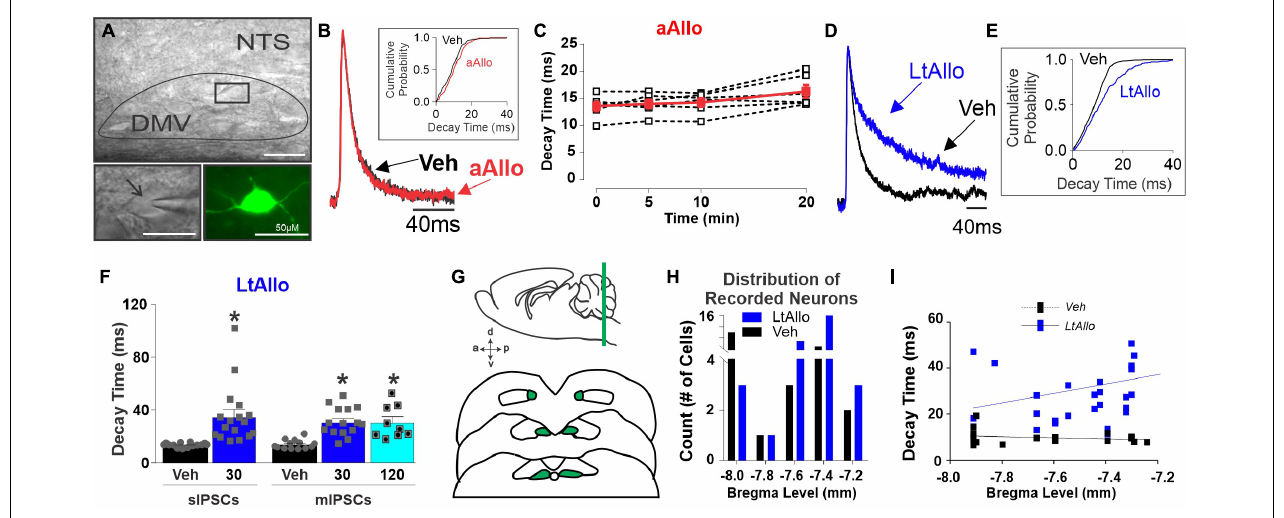
FIGURE 1 | Long-term allopregnanolone (LtAllo) in the dorsal motor nucleus of the vagus (DMV) prolongs phasic γ -aminobutyric acid A (GABA A ) receptor inhibitory postsynaptic current (IPSC) decay kinetics. (A) Top panel: Diffusion contrast imaging of representative DMV neurons with patch pipette. Bottom left panel: Magnification of boxed region in top panel containing a single DMV neuron with patch pipette. Bottom right panel: DMV neuron recovered by biotin-avidin-texas red staining (pseudo-colored green). The scale bar represents 50 µ m. Black arrow indicates pipette. (B) Averaged trace of spontaneous (s)IPSCs in DMV neurons during Vehicle (Veh, black) and (acute)Allo (aAllo; red, 5 min application) during a paired treatment design. Averaged traces were normalized for amplitude. Inset graph shows a representative sIPSC cumulative probability of decay time during Veh and aAllo (5 min) treatment in a DMV neuron. (C) Mean ± SEM of sIPSCs decay time during Veh-application (13.6 ± 0.9 ms) and aAllo-application (100 nM) at 5- (14.0 ± 0.8 ms; n = 6 from 3 mice), 10- (14.3 ± 0.8 ms) and 20-min (16.4 ± 1.2 ms; p = 0.08) in red. Overlaid points denote individual DMV neuronal responses (black); One-way repeated measure ANOVA. (D) An averaged trace of sIPSCs in DMV neurons from a Veh- (black) and a LtAllo-treated (blue) neuron. Averaged traces were normalized for amplitude. (E) The representative cumulative sIPSC probability of decay time in DMV neurons from a vehicle-treated (Veh, black) and a LtAllo-treated (blue) neuron. LtAllo shifts the probability to the right. (F) Mean ± SEM of IPSCs decay time in Veh- (black bars) and LtAllo-treated (blue bars) neurons. Left panel demonstrates sIPSCs decay time from LtAllo- (35.1 ± 5.3 ms; n = 17 from 9 mice) and Veh-treated (13.2 ± 0.4 ms; n = 14 from 10 mice) DMV neurons. Right panel is mean ± SEM of IPSC decay time after application of the sodium channel blocker, tetrodotoxin (TTX; mIPSCs). The LtAllo-induced prolongment of decay time in DMV neurons was TTX resistant at 30-min (31.5 ± 2.8 ms; n = 15 from 9 mice) and 120-min (31.6 ± 4.1 ms; n = 9 from 4 animals) compared to Veh-treated (14.2 ± 1.0 ms; n = 13 from 7 mice). Overlaid points denote individual neuronal responses; unpaired Student’s t -test for sIPSCs; One-way ANOVA with Tukey’s post hoc for mIPSCs. (G) Representative diagram illustrates the rostral-caudal distribution of recorded neurons in the DMV. (H) Distribution of Veh- (black) and LtAllo-treated (blue) neurons recorded experiments (Veh, n = 49; Allo, n = 48) plotted as a function of their relative bregma location. (I) Correlational analysis of average IPSC decay time across bregma level in Veh-treated (black with dashed line) compared to LtAllo-treated (blue with solid line) neurons. Each square represents a single neuron. Rostrally located DMV neurons correlate more strongly with larger decay times after LtAllo. *Denotes significant difference from Veh. DMV: dorsal vagal motor neurons; NTS: nucleus tractus solitarius. Significance indicates p ≤